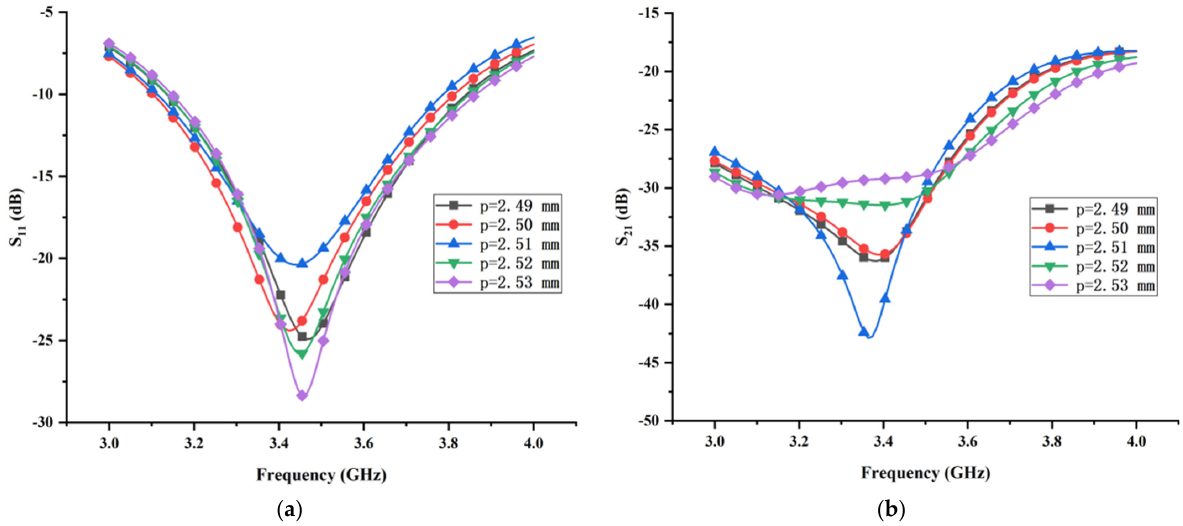
Figure 13. The effects of the periodic distance p of the metallic vias on ( a ) reflection coefficient and ( b ) transmission coefficient. ( b ) transmission